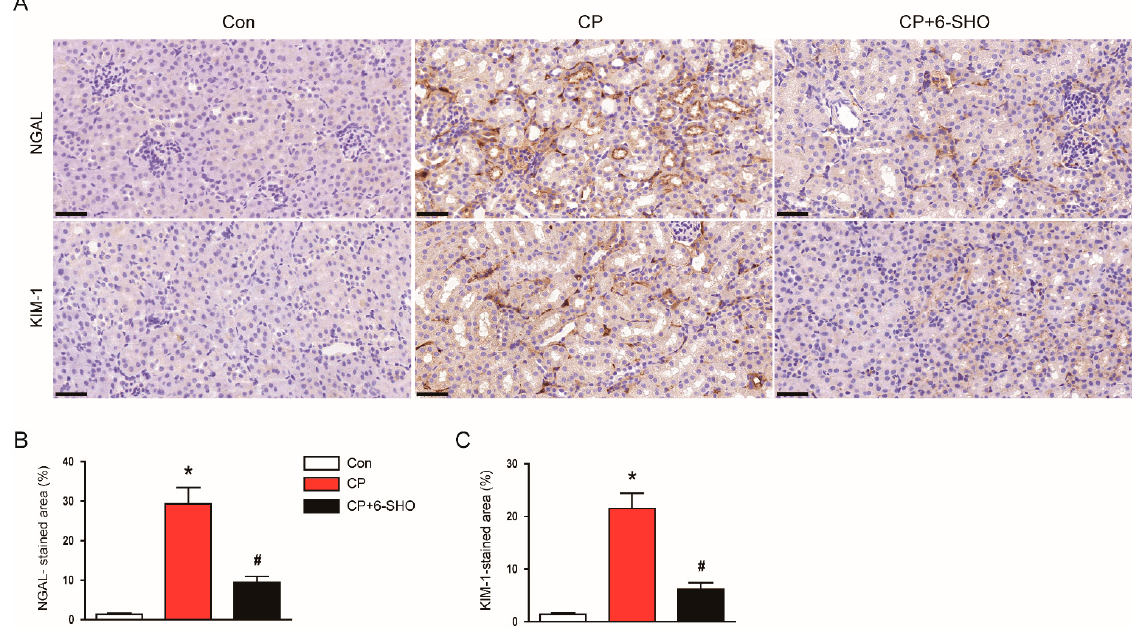
Figure 3. Effect of 6-shogaol on expression of neutrophil gelatinase-associated lipocalin (NGAL) and kidney injury molecule-1 (KIM-1) in cisplatin-treated mice. ( A ) Representative images of immunohistochemistry (IHC) staining for NGAL and KIM-1. Scale bar = 40 μ m. ( B ) Quantification of positive staining for NGAL. ( C ) Quantification of positive staining for KIM-1. n = 8 per group of mice. * p < 0.05 versus Con. # p < 0.05 versus CP.